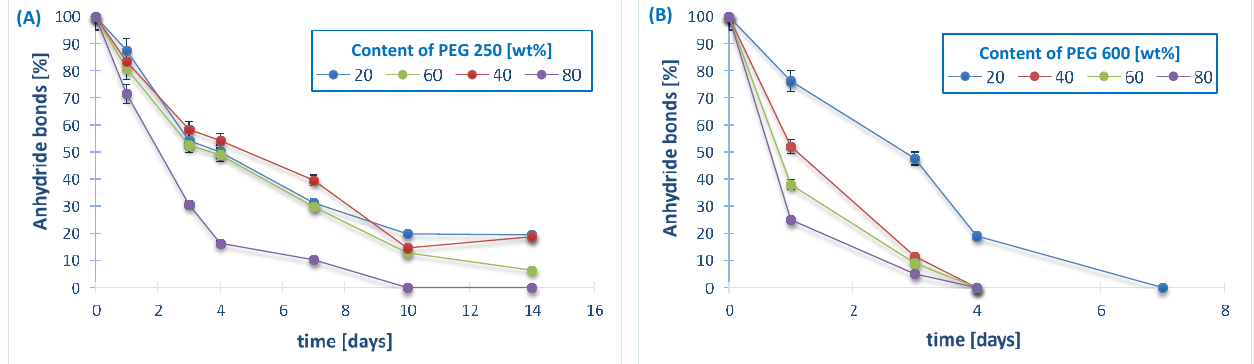
Figure 5. Anhydride bond loss of copolymers based on PEG 250 ( A ) and PEG 600 ( B ) in the air at 25 °C ( n = 3, error bars, standard deviation).